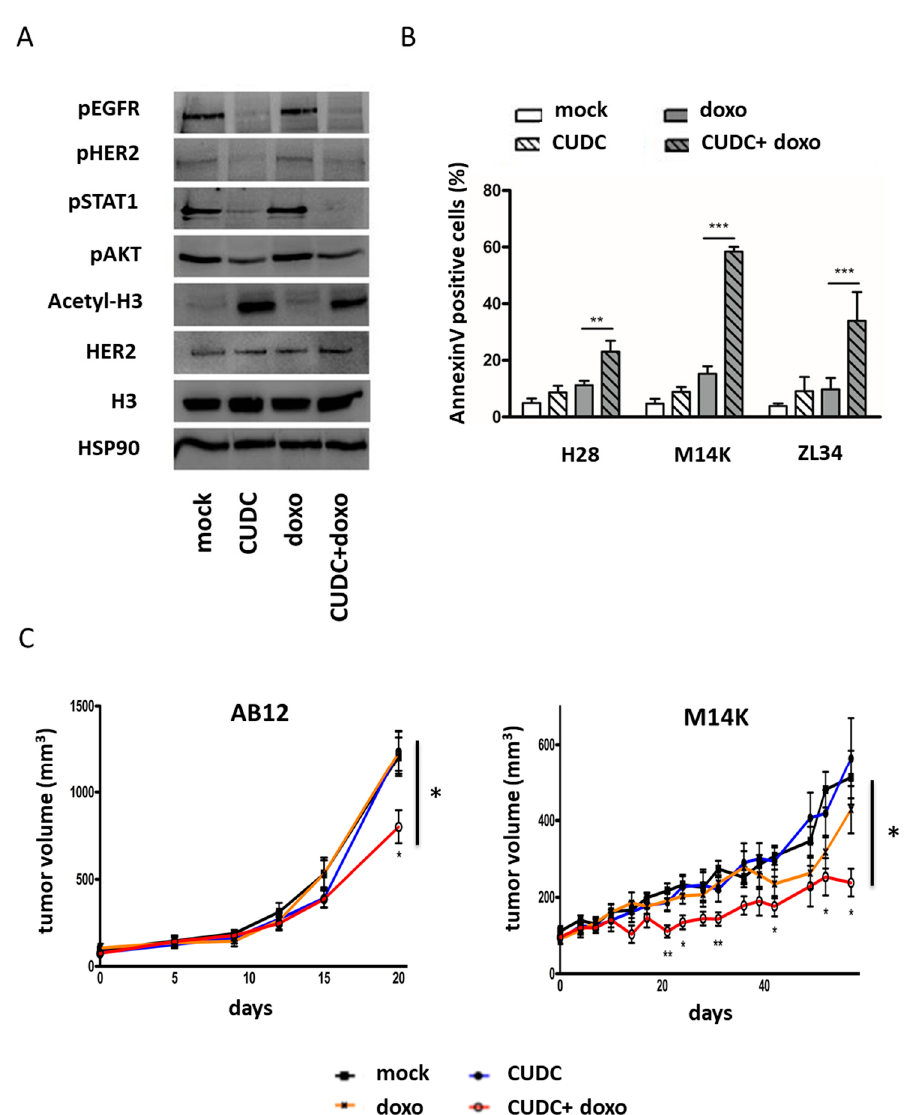
Figure 4. An inhibitor targeting EGFR / HER2 and HDAC synergizes with doxorubicin to induce apoptosis and inhibit tumor growth. ( A ) Representative immunoblotting of H28 cell lysates evaluating the phosphorylation of EGFR, STAT1, AKT and HER2 as well as the acetylation of histone H3 in response to doxorubicin and / or the EGFR / HER2 / HDAC inhibitor (CUDC-101 at 1 µ M). Heat-shock protein 90 (HSP90) was used as a loading control. ( B ) The apoptosis induced by CUDC-101 (1 µ M) and / or doxorubicin (100 nM) was quantified by an Annexin V assay in three mesothelioma cell lines (H28, M14K and ZL34). Data represent the means ± SD of three independent experiments. Statistical significance was determined with one-way analysis of variance (ANOVA) followed by Tukey’s multiple comparisons test. ** p -value < 0.01; *** p -value < 0.001. ( C ) Tumor growth of AB12 (murine) and M14K (human) mesothelioma cells was evaluated after subcutaneous injection in BALB / c and NOD-SCID mice, respectively. Mice were treated intraperitoneally with mock (30% Captisol), doxorubicin (0.5 mg / kg once a week) or / and CUDC-101 (100 mg / kg twice a week). The tumor volume was measured at regular intervals. One-way analysis of variance (ANOVA) was used at the di ff erent time points to evaluate the statistical significance (* p -value < 0.05; ** p -value < 0.01) between the di ff erent treatment conditions (six mice per group).